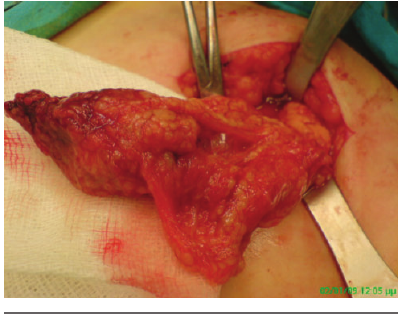
Figure 1. Omental inflammatory mass with signs of necrotic tissue.